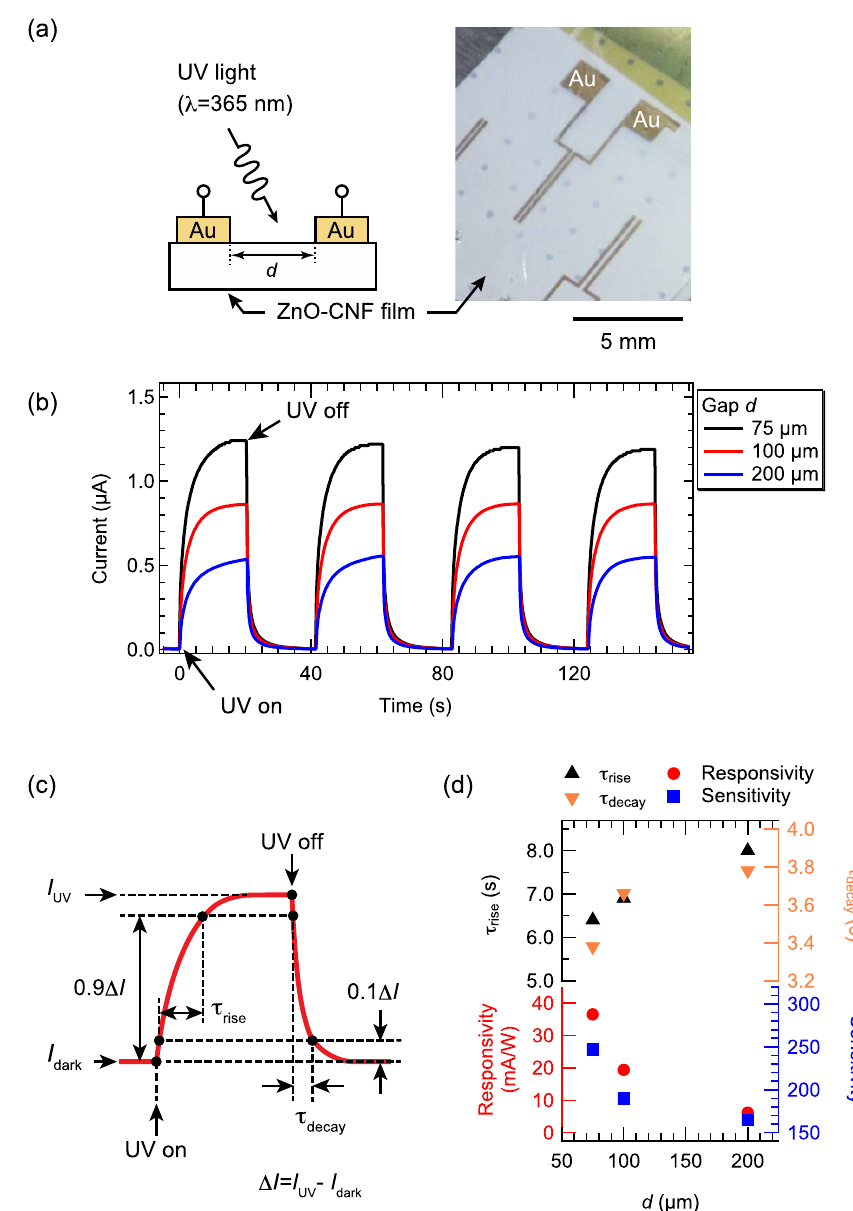
Figure 5. ( a ) Schematic illustration and photograph of the measurement setup. The suction holes of the I–V prober are visible through the ZnO–CNF film because the film is translucent. ( b ) Time evolution of UV light-induced photocurrent for the films with various ZnO contents at the applied voltage of 1.2 V. ( c ) Schematic illustration of one on/off UV cycle indicating the definition of I UV , I dark , ∆ I , rise time ( τ rise ), and decay time ( τ decay ). ( d ) τ rise , τ decay , responsivity, and sensitivity as a function of the electrode gap, which were estimated from Figure